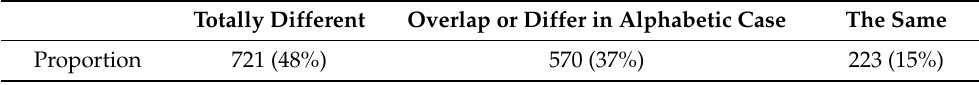
Table 3. Vocabulary differences between CN and HCN. Totally Different Overlap or Differ in Alphabetic